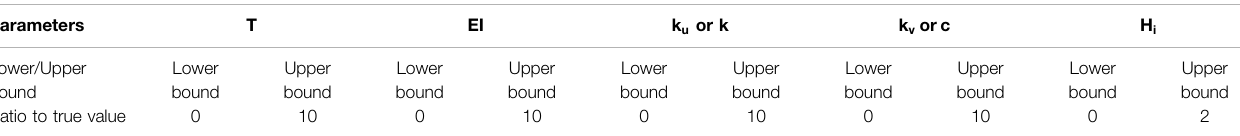
TABLE 3 | Solution range when solving optimization problem in numerical veri fi